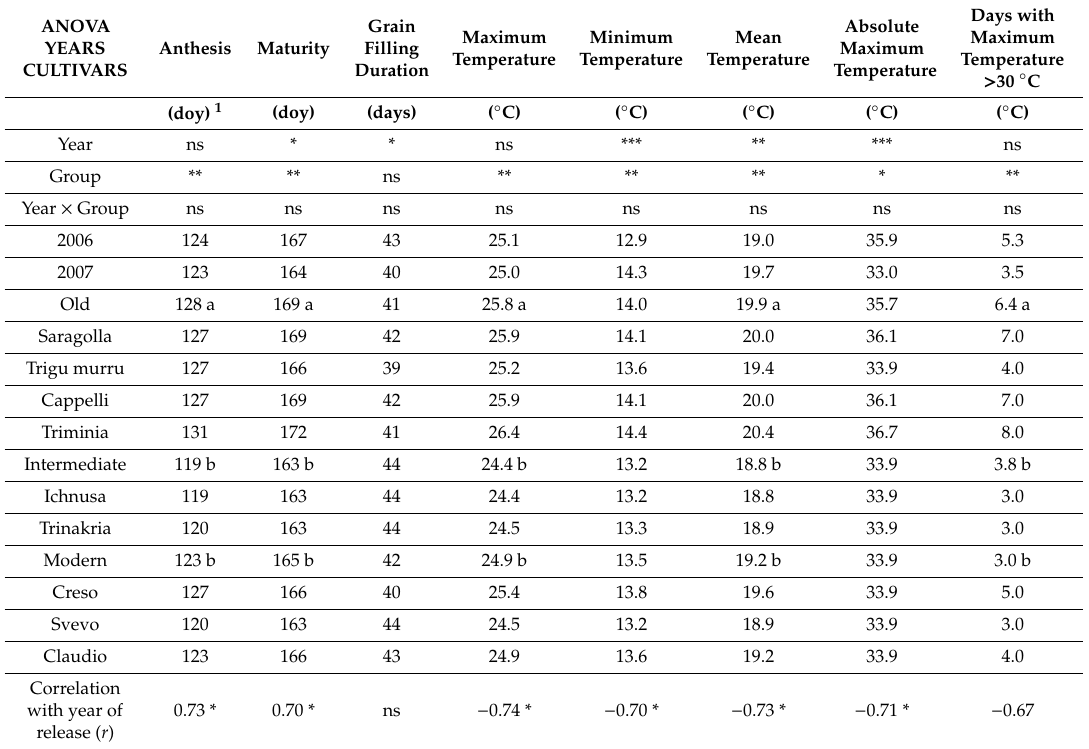
Table 2. Phenologicaltraitsandtemperaturesduringgrainfilling. ANOVAresults,means,andcoefficient of correlation ( r ) with the year of